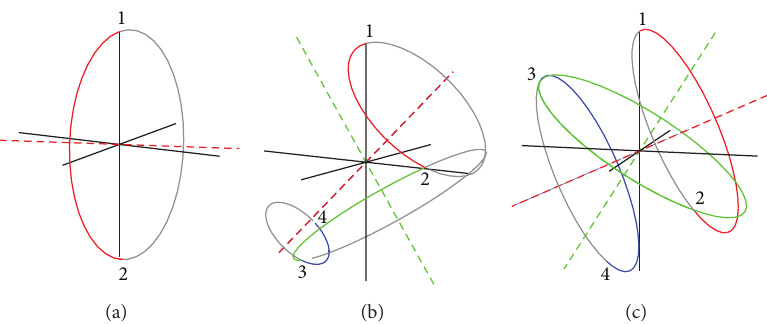
Figure 9: Graphic representation of transition in different points of oscillogram: peak due to MSW resonance in the mantle (left), peak due to parametric enhancement of transition driven by 1–3 mixing (middle), and peak due to parametric enhancement of transition driven by 1-2 mixing (right). In the left panel, neutrinos traverse only the mantle layer. In the right panel, neutrinos traverse the mantle (red), the core (green), and again the mantle (blue). The dashed lines correspond to the Hamiltonian vector H for the mantle (red) and core (green),